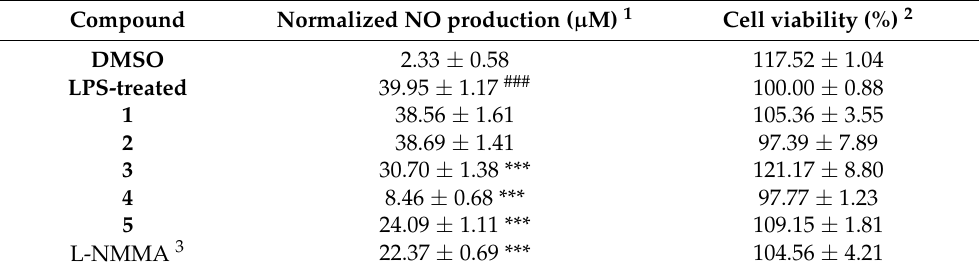
Table 2. Inhibitory effects on NO production of compounds 1–5 at 20 µ M in LPS-stimulated BV-2